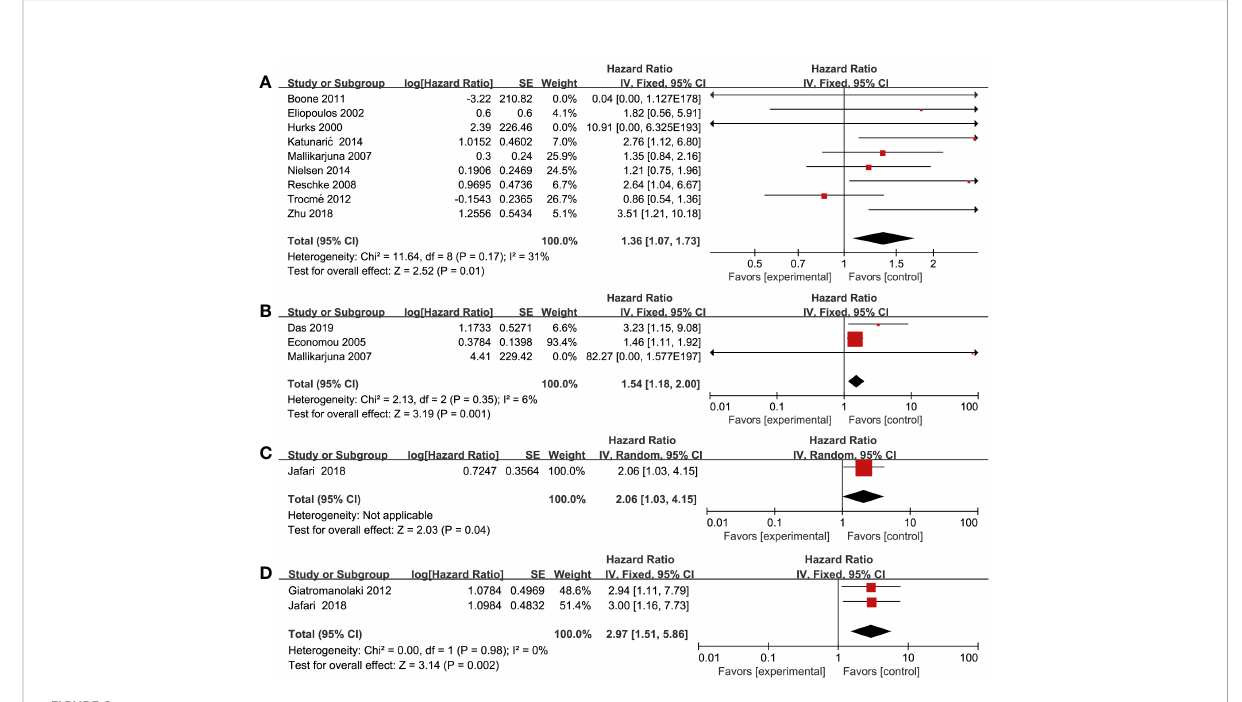
FIGURE 2 Forest plot illustrating the association between various RTKs and OS in melanoma. (A) EGFR, (B) MET, (C) VEGF-R1, (D)